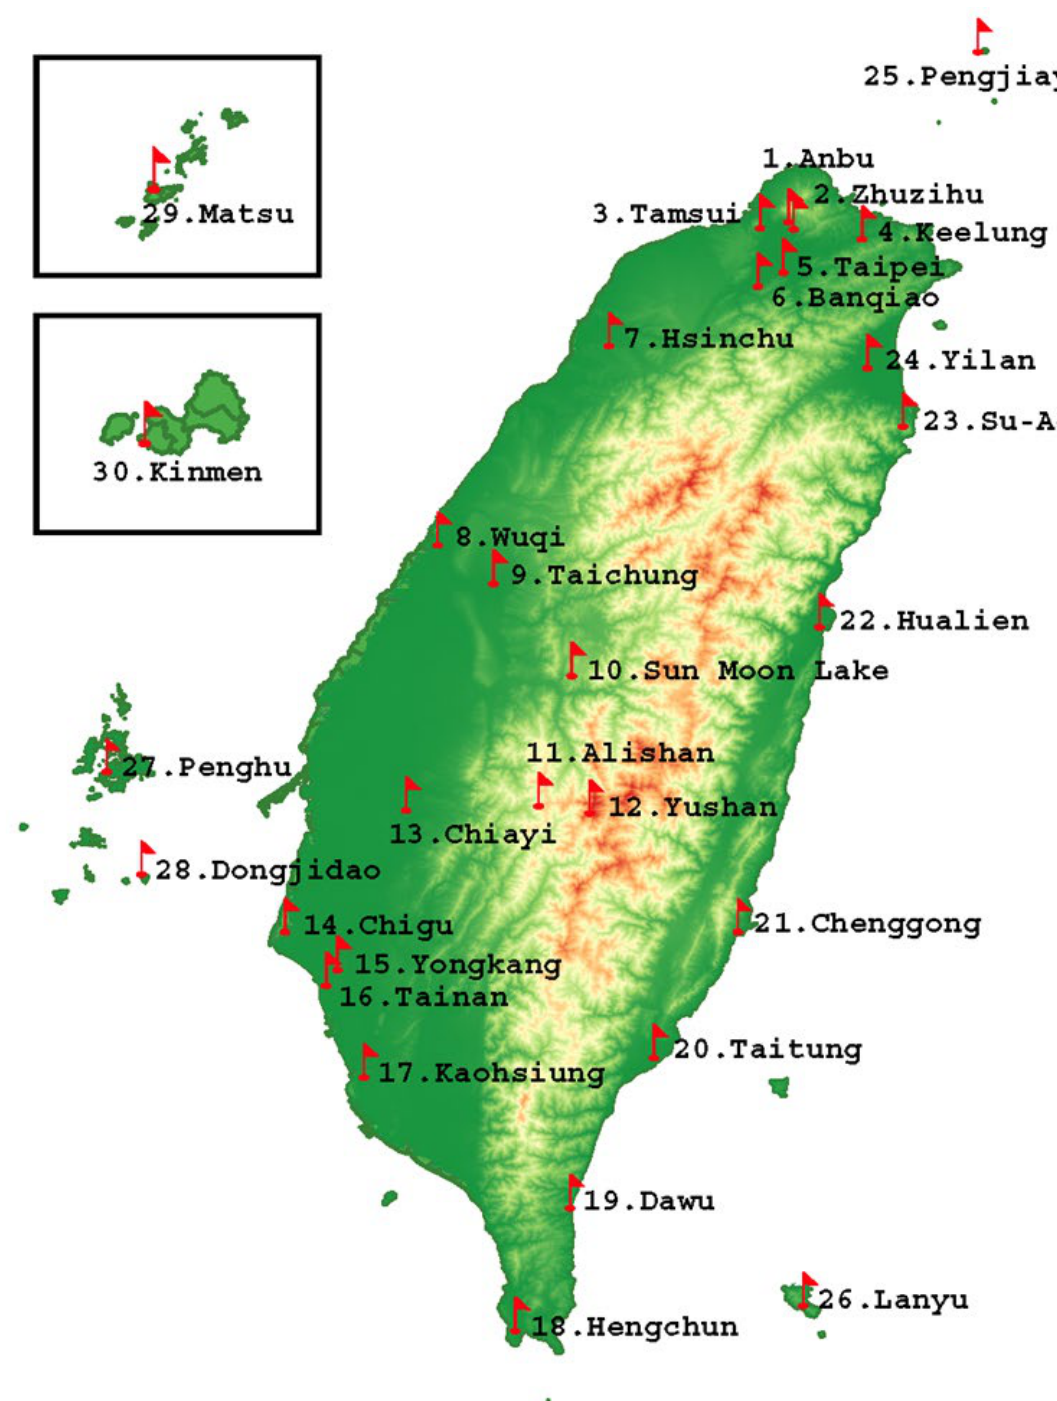
Figure 1. Locations of the 30 weather stations in this study.